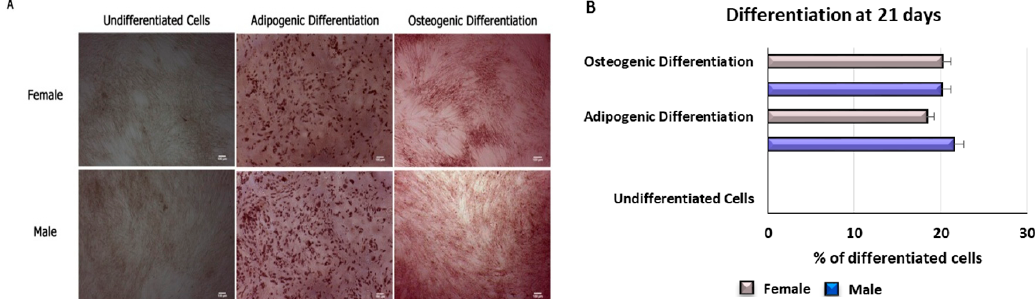
Figure 2. Differentiation of WJ-MSCs after 21 days. ( A ) Differentiation of female and male WJ-MSCs after treatment in specific adipogenic or osteogenic differentiation medium. Undifferentiated cells are WJ-MSCs cultured in basic growing medium. Scale bar = 100 µm. The percentage of differentiation ( B ) was calculated using ImageJ, with WJ-MSCs cultured for 21 days in osteogenic or adipogenic medium. Data are expressed as mean ± SD and are representative of n different experiments. An average was made from three technical replicates.